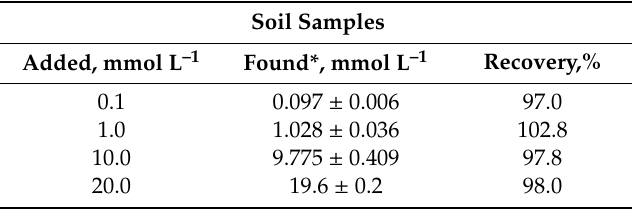
Table 3. Assessment in spiked soil extracts